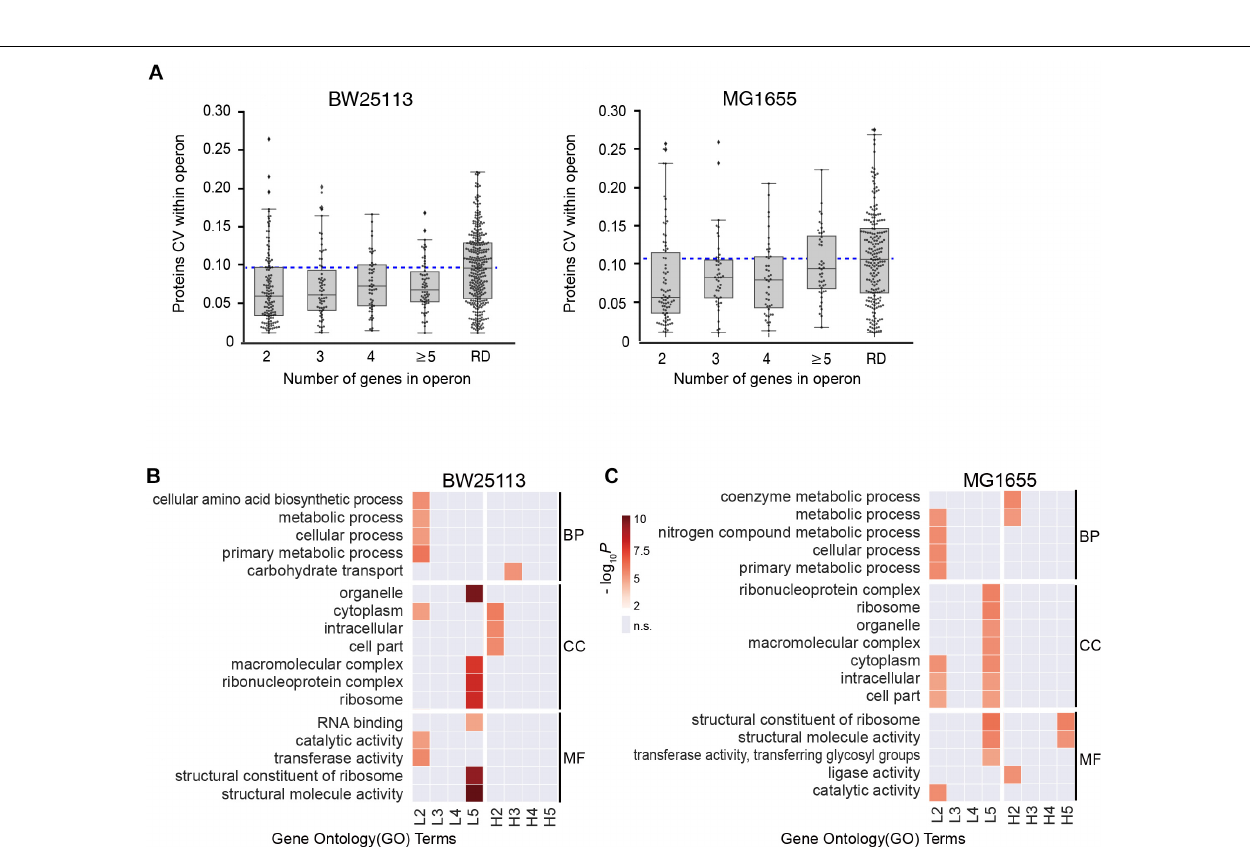
FIGURE 3 | Functional-dependence of operon stoichiometry control. (A) Protein CVs within operons, categorized according to the number of genes in operon. RD, randomized data. Blue dashed line represents the median of the randomized data. (B,C) Gene ontology (GO) overrepresentation of the operons with lower CV than the randomized median (L2–L5) and higher CV than the randomized median (H2–H5). The number refer to the number of genes in operon. GO terms with P > 0.001 were considered insignificant and marked as gray. BP, biological process; CC, cell component; MF, molecular function. (B) BW25113 and (C) MG1655 strain.